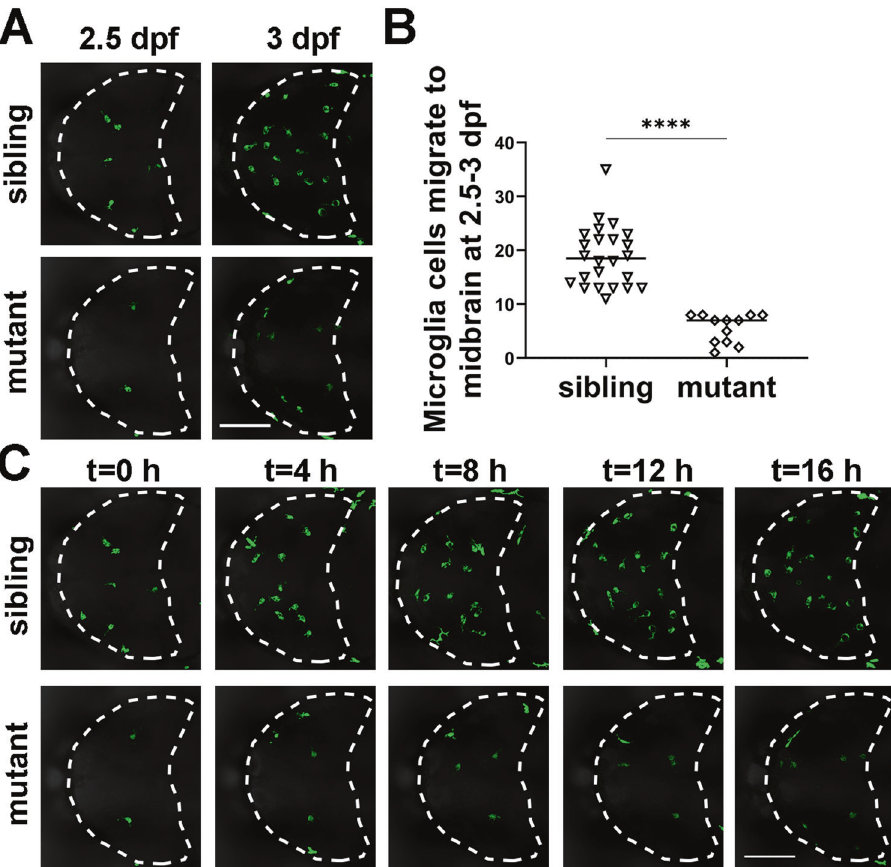
Fig. 5 dock8 de fi ciency reduce microglia colonization in zebra fi sh early larvae. A Representative images of GFP + microglia in dock8 -15, + 5bp ; Tg(coro1a:GFP) embryos from 2.5 dpf – 3 dpf for 10 – 16 h. B Quanti fi cation of GFP + microglia migrating into the midbrain from 2.5 dpf to 3 dpf in dock8 -15, + 5bp ; Tg(coro1a:GFP) embryos. C Time-lapse confocal imaging of microglia colonization in dock8 -15, + 5bp ; Tg(coro1a:GFP) embryos from 2.5 dpf – 3 dpf. Each dot represents one larva. White dotted lines indicate the midbrain. Scale bar = 100 µm. See also Video S2. Data were analyzed by unpaired Student ’ s t -tests. **** P ≤ 0.0001 dock8 -2bp -rev: 5 ′ -gagacataattcacgcctac-3 ′ ; dock8 -15, + 5bp -fwd: 5 ′ -tggcactga- gatgagacacc-3 ′ , dock8 -15, + 5bp -rev: 5 ′ -ggttgtccttcatctacgtg-3 ′ ; cdc42 -20bp - fwd: 5 ′ -catgccatgacctgtctcgt-3 ′ , cdc42 -20bp -rev: 5 ′ -cagtacctgcagtatcaaac-3 ′ ; cdc42l -29bp -fwd: 5 ′ -ctaatgtgtgacgtccagtg-3 ′ , cdc42l -29bp -rev: 5 ′ -actggctata- cacatcagac-3 ′ . Genotypes of dock8 -2bp or dock8 -15, + 5bp mutants were determined by BsaJI digestion of the PCR products. Genotypes of